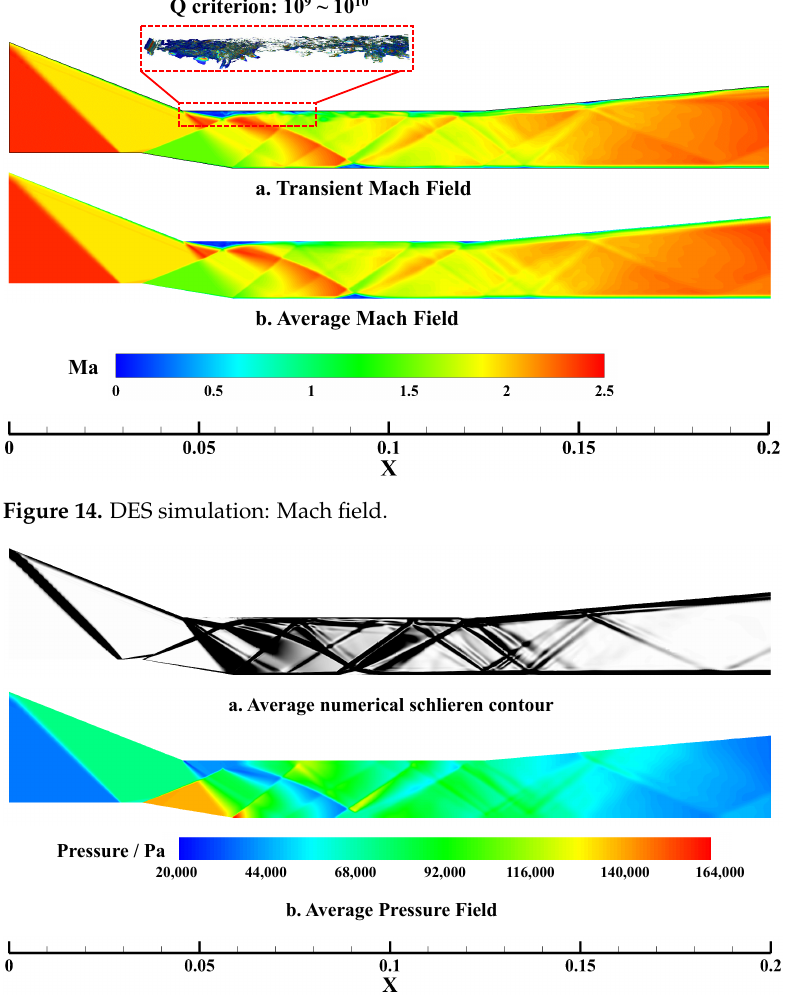
Figure 15. DES simulation: average fields of density gradient and